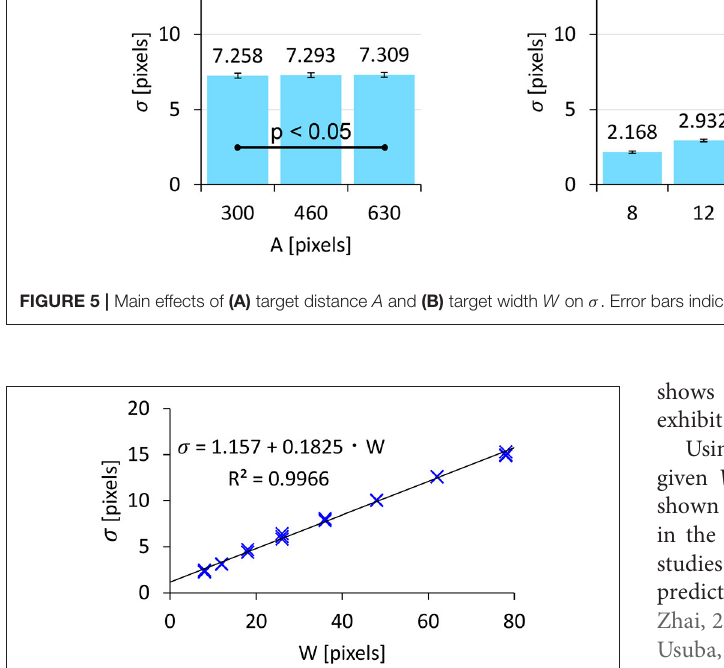
FIGURE 6 | Model fitness results for click point